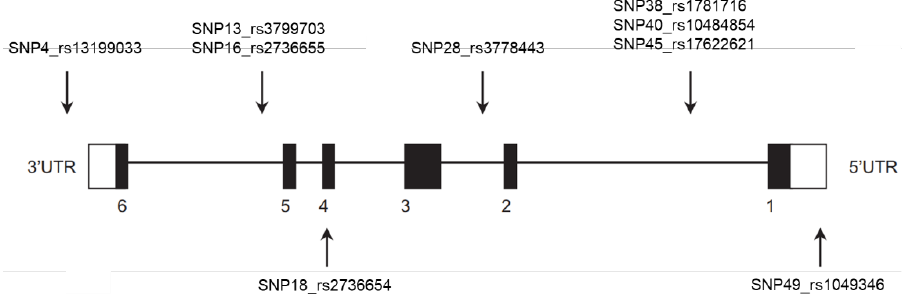
Figure 1. Representation of the human glyoxalase 1 gene. Arrows indicate the approximate locations of the nine single nucleotide polymorphisms (SNPs) genotyped in this study. Black boxes represent exons and untranslated regions (UTRs) of the first and last exon are indicated as white boxes. SNP4 is located on the 3′ untranslated region; SNP18 in exon 4 (nonsynonymous); SNP49 in exon 1 (untranslated region); and all other SNPs are located in introns.